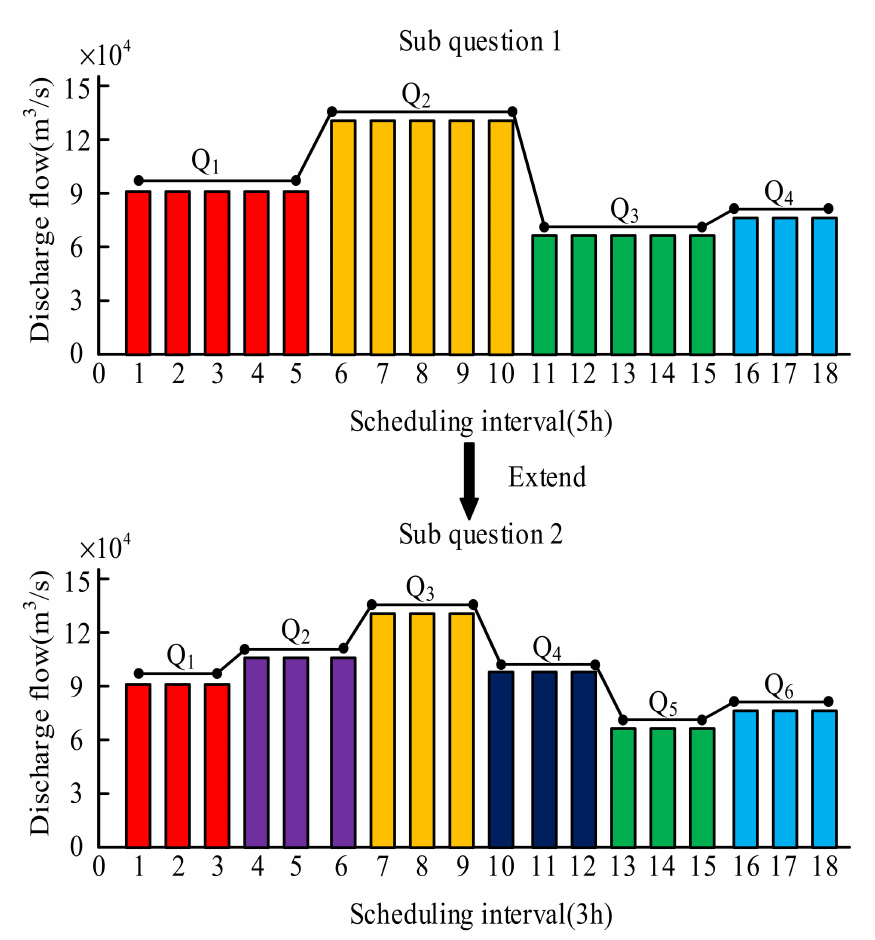
Figure 4. Schematic diagram of sub-problem expansion